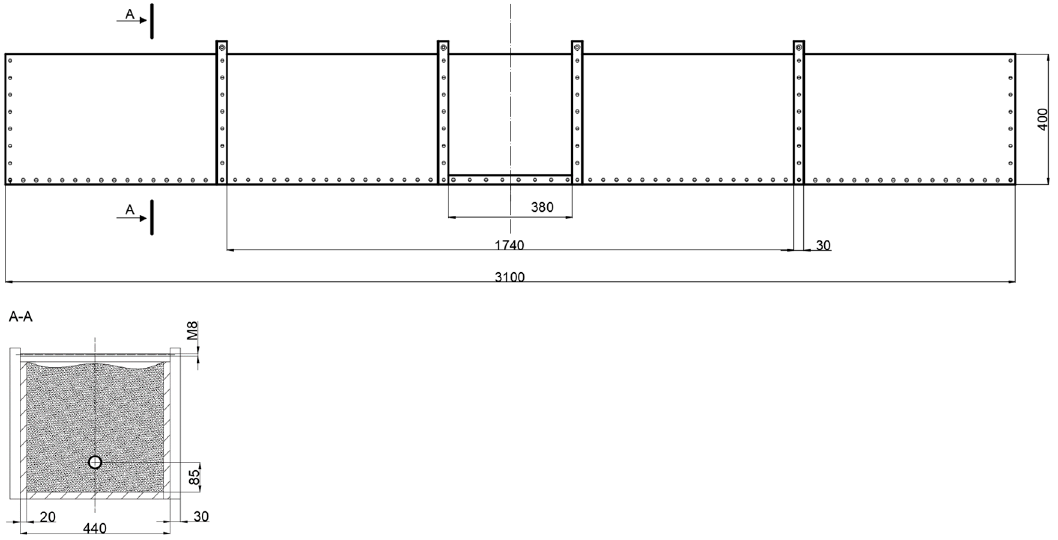
Figure 5. Schematic of the test stand. (Units in mm).